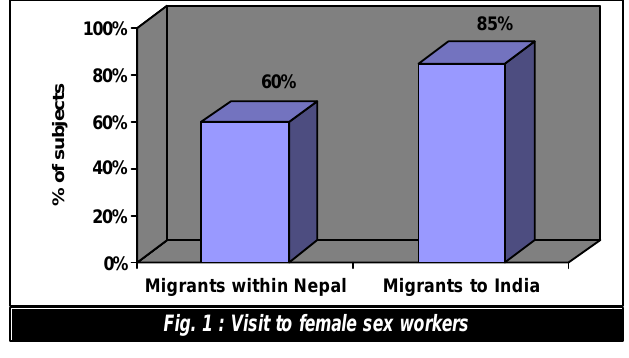
Fig. 1 : Visit to female sex